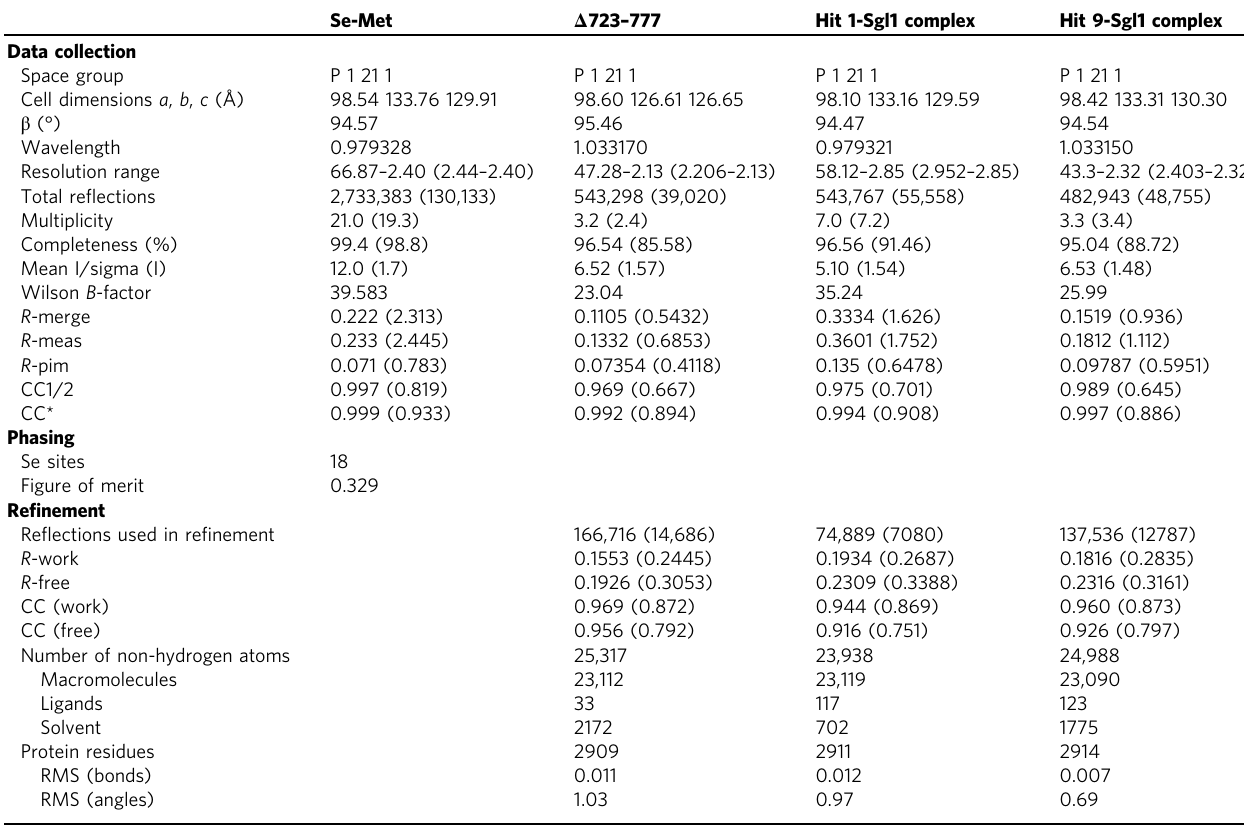
Table 1 Data collection and re fi nement